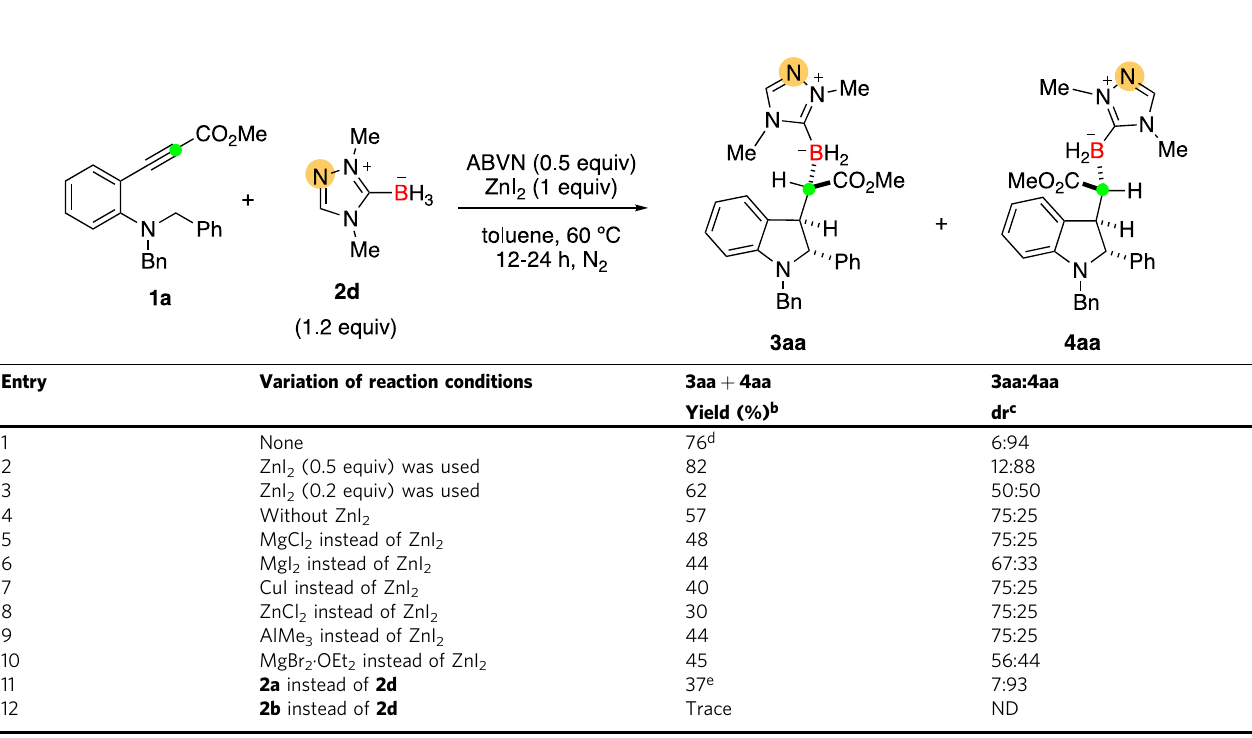
Table 2 Examination of reaction parameters for the preferential formation of diastereomer 4aa a